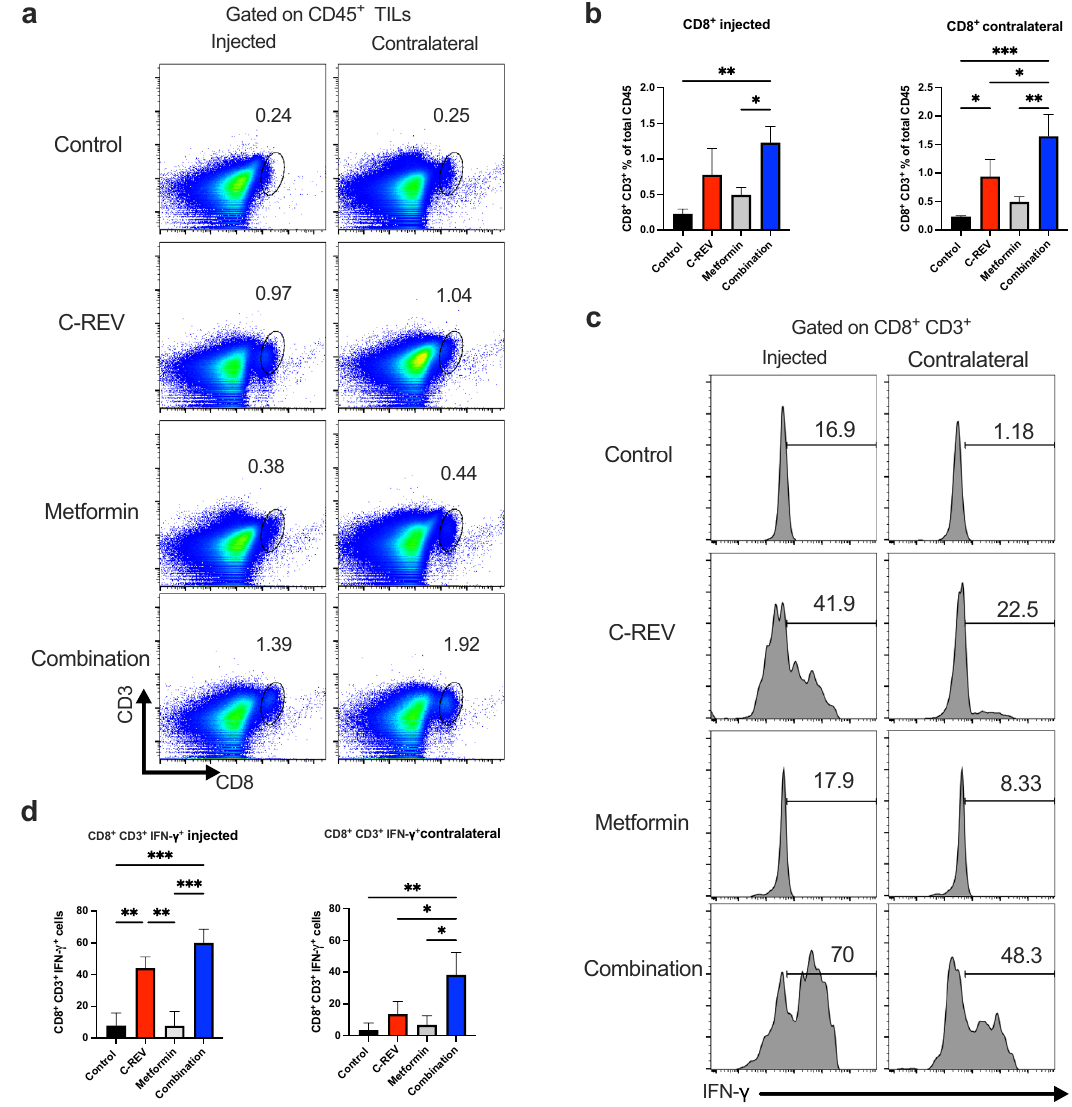
Figure 2. Combination therapy enhances infiltration and IFN-γ production from CD8 + CD3 + TILs. Mice were inoculated with Pan02 tumors as indicated in Fig. 1a, on day 14 after combination treatment, tumors from both injected and contralateral sides were harvested, dispersed into single cells by enzyme digestion, and stained with the indicated antibodies. Percentages of each population in each group are displayed in bar graphs. ( a ) Dot charts show CD8 + CD3 + T cells from Pan02 tumors on the injected and contralateral sides. ( b ) Bar graphs show the percentage of CD8 + CD3 + cells on the injected and contralateral sides. ( c ) Mice were inoculated with Pan02 tumors as in Fig. 1a, on day 14 after combination treatment, tumors and TDLNs were harvested and CD8 + CD3 + TILs were isolated by MACs and subjected them to anti-CD3/anti-CD28 antibody stimulation for 2 days. Histograms show representative intracellular IFN-γ production from CD8 + CD3 + TILs cells on the injected and contralateral sides. ( d ) Bar graphs show the percentage of IFN-γ production from CD8 + CD3 + TILs cells on the injected and contralateral sides. Data are presented as mean ± SD (n = 3 mice). One-way ANOVA with a post- hoc Tukey’s tests was performed. * p < 0.05, ** p < 0.01, *** p <